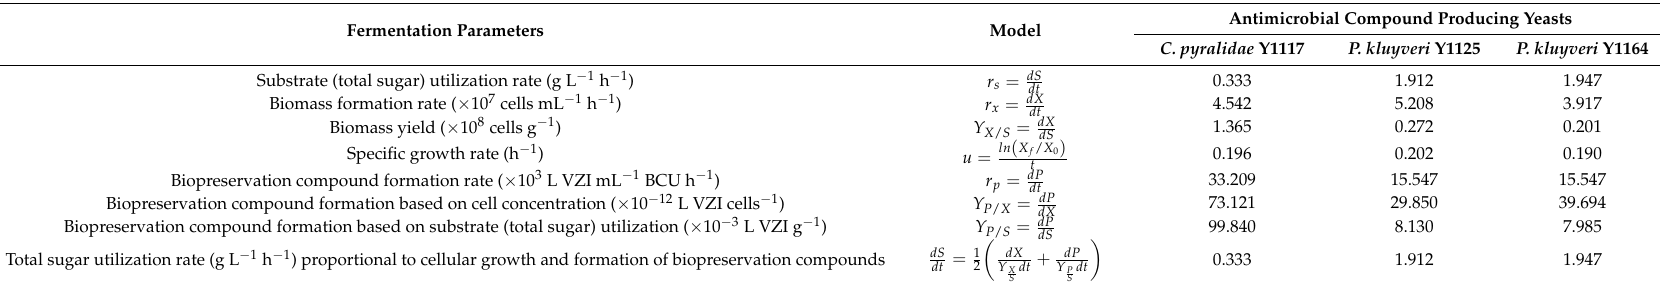
Figure 3. Biopreservation compound production in a grape pomace extracts medium by Candida pyralidae Y1117 ( a ), Pichia kluyveri Y1125 ( b ) and P. kluyveri Y1164 ( c ) in a single stage bioreactor at the total sugar concentration of 150 g L − 1 . Table 2. Kinetics of biopreservation compound production by Candida pyralidae Y1117, Pichia kluyveri Y1125 and P. kluyveri Y1164 using grape pomace extracts broth (total sugar concentration of 150 g L − 1 ) as fermentation medium.